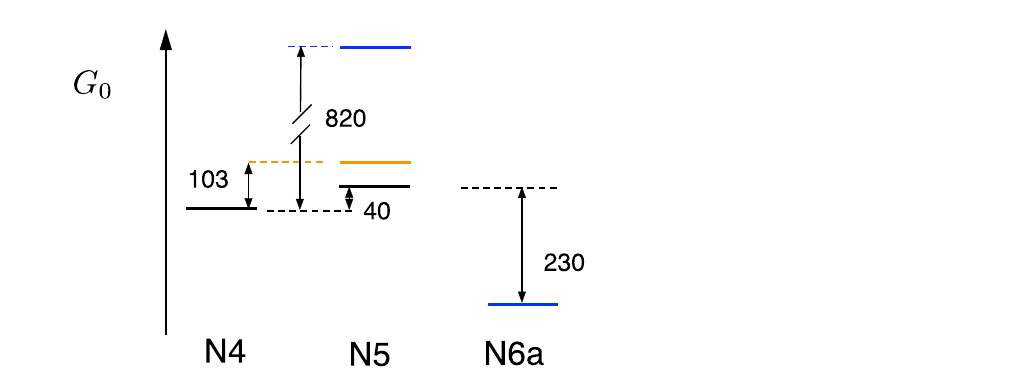
Figure 4. Effect of polarizability. The transition dipoles in the Hamiltonian matrix were scaled, μ jk → ξμ jk , to determine the effect of the cofactor polarizability on the energetics of the forward N4 − → N5 (blue) and backward N5 − → N4 (orange) transitions. ( a ) Free energy surfaces at ξ = 0 (black, solid lines indicate the Marcus theory), ξ = 1, and ξ = 2 (marked in the plot). ( b ) λ 1 (N4 − → N5, blue) λ 2 (N5 − → N4, orange), and their mean (dashed black). The Stokes shift reorganization energy λ St is marked solid black. ( c ) The activation barrier Δ G † . ( d ) The polarizability of N4 in the ground-state spin state.